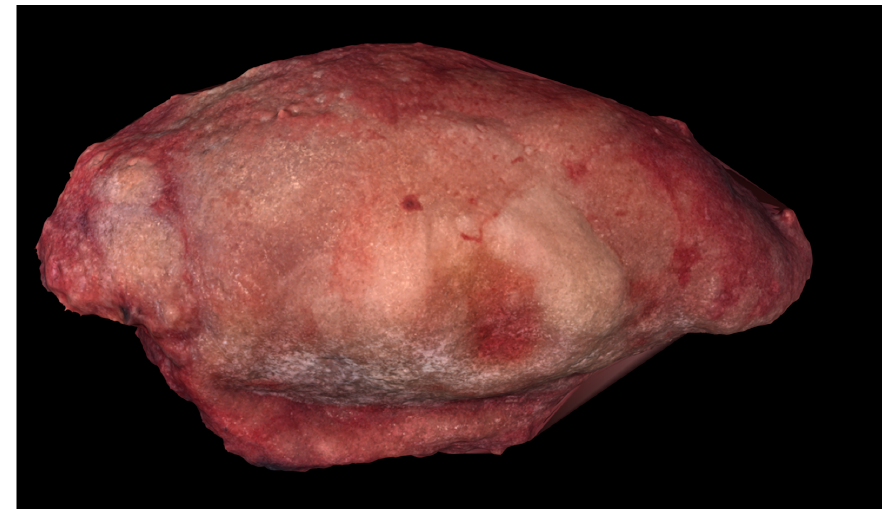
Figure 5. Digital 3D model of Case 2 using Meshlab.